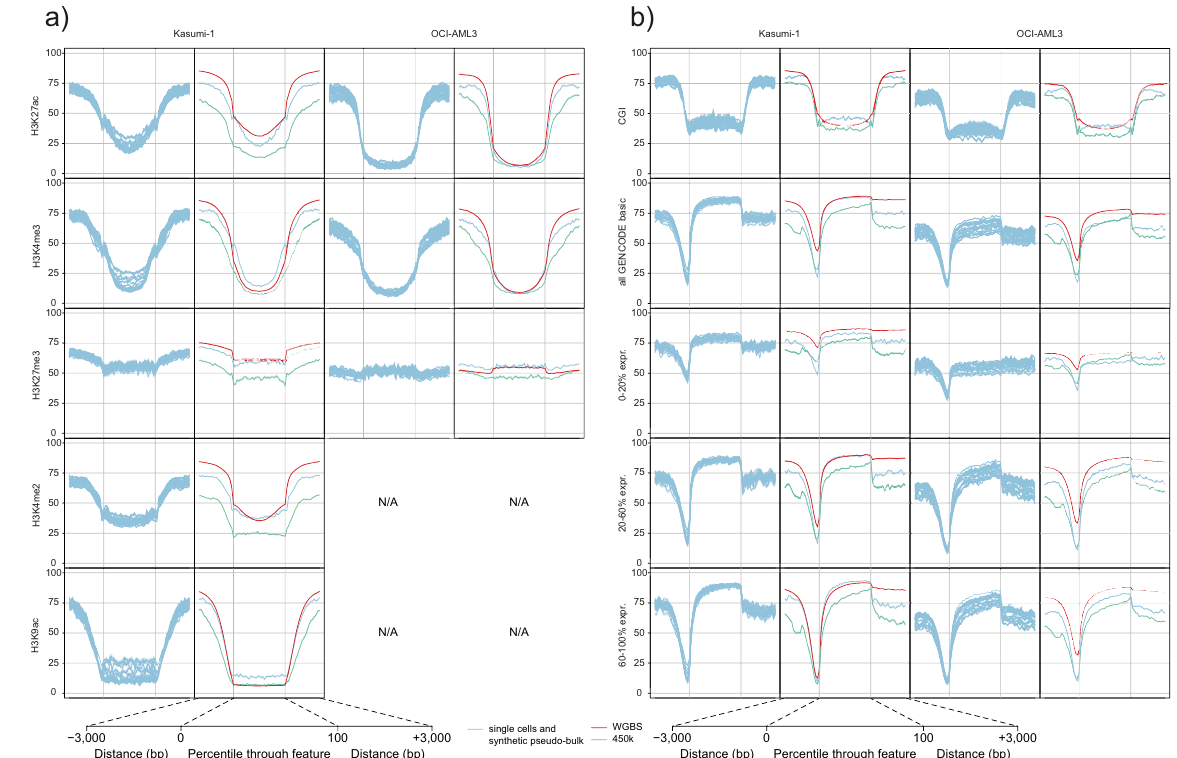
Fig. 2 Single-cell methylation pro fi les and comparison of corresponding pseudo-bulk pro fi les with WGBS and 450 K array cell-bulk pro fi les. a Averaged epi-gSCAR methylation pro fi les (K_08 – K_27 and O_01 – O_20; light blue lines) and corresponding pseudo-bulk (light blue lines) and cellbulk pro fi les (WGBS, red lines; 450 K array, green lines) across fi ve histone marks. b Averaged epi-gSCAR methylation pro fi les (K_08 – K_27 and O_01 – O_20; light blue lines) for CGIs, all genes (all GENCODE basic genes) and genes grouped into three groups (0 – 20%, >20 – 60%, and >60 – 100%) based on their RNA expression level in cell bulk as FPKM (fragments per million mapped reads per kilobase exon), and corresponding pseudo-bulk (light blue lines) and cell-bulk pro fi les (WGBS, red lines; 450 K array, green lines). For plotting of pseudo-bulk datasets, we used HhaI sites covered in at least 5 of 20 single cells in order to reduce coverage bias. Shown is the mean methylation across 150 bp windows for each feature set and 3 kb upstream and